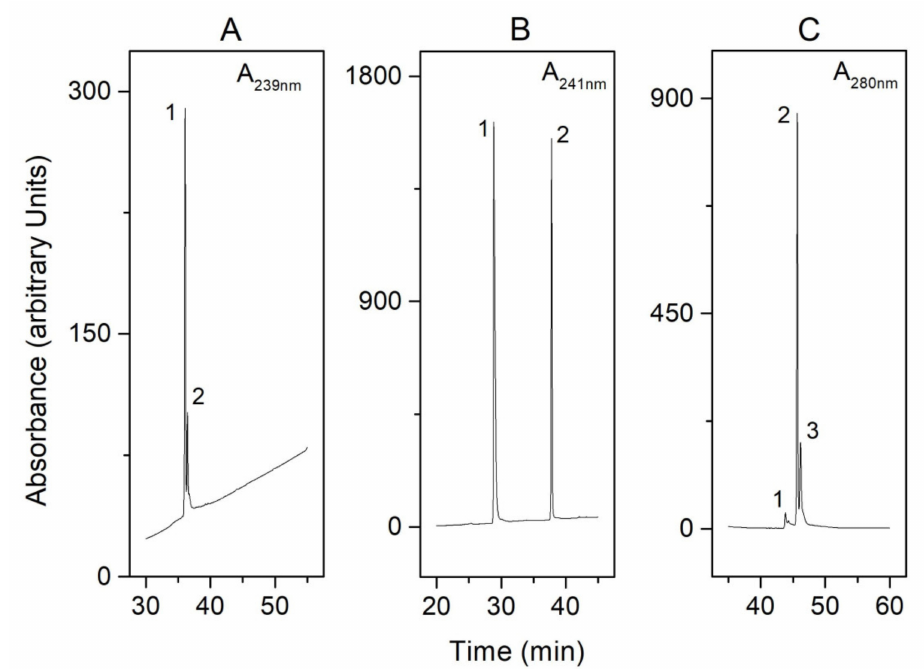
Figure 1. HPLC gradient analysis of drugs examined for their interaction with hydrogel lenses. X axis: elution time through the chromatographic column. Y axis: absorbance intensity at the specific wavelength used for each drug (dexamethasone, 239 nm; chloramphenicol and betamethasone, 241 nm; bromophenacyl bromide, 280 nm). Panel ( A ): peak 1 dexametyhasone; peak 2 background signal. Panel ( B ): peak 1 chloramphenicol, peak 2 betamethasone. Panel ( C ): peak 2 bromopheanc, peaks 1 and 3 background signals. The identity of each peak was confirmed by mass spectrometry analysis (see Materials and Methods). Background signals are due to contaminants disagreeing with the theoretical molecular weight of the drugs analyzed.